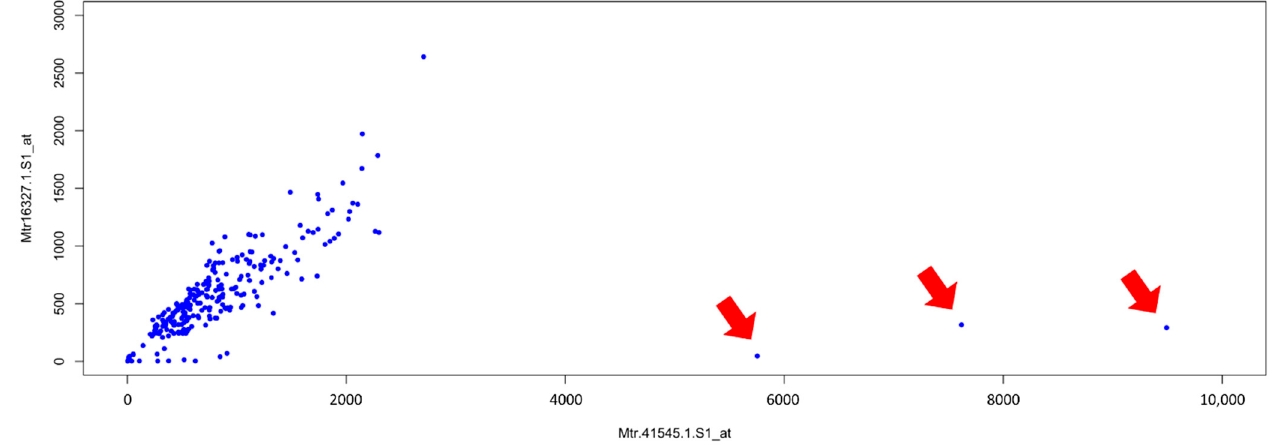
Figure 1. Scatterplot of the mean expression levels of probes Mtr.41545.1.S1_at and Mtr.16327.1.S1_at. Three outliers are indicated by red arrows.